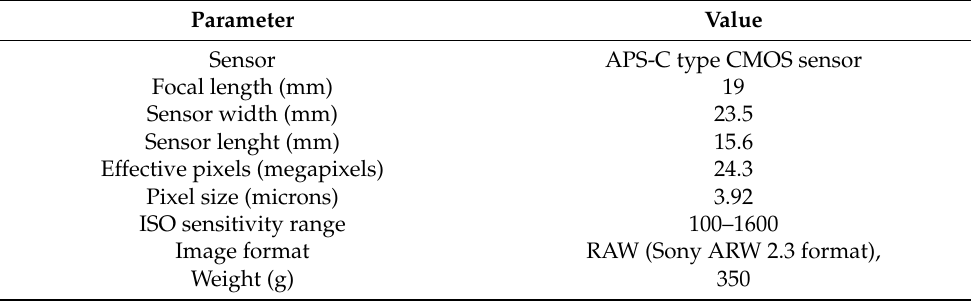
Table 2. Sony NEX 7 camera sensor parameters.